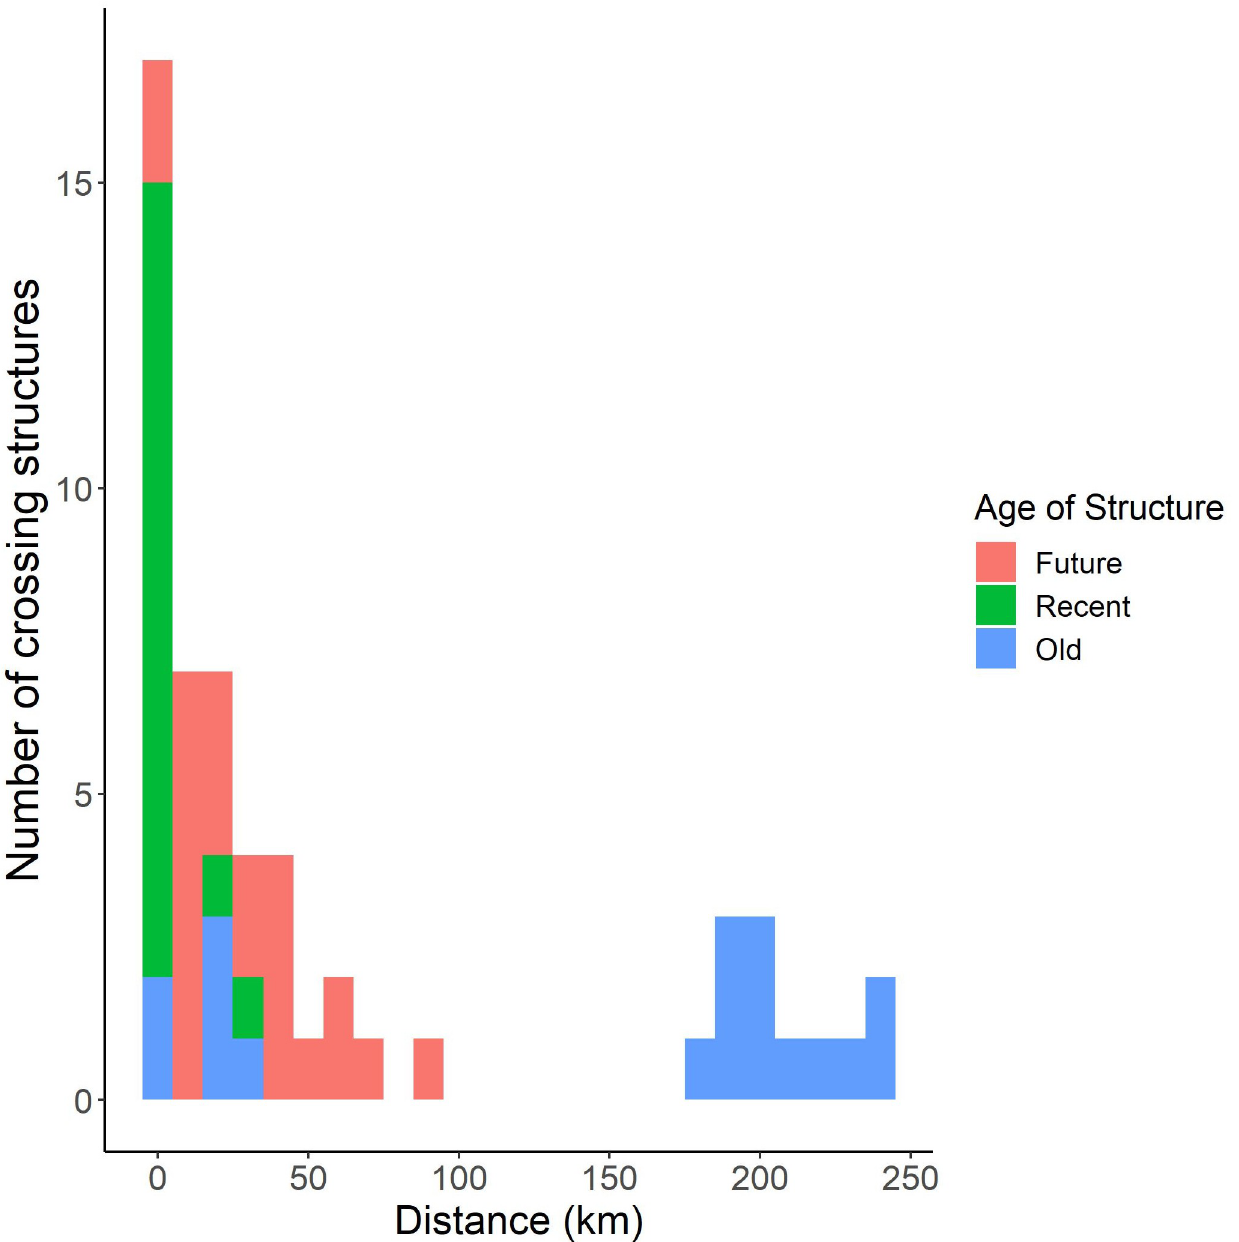
Fig 5. Histogram depicting the distance between each of the 56 crossing structures to the nearest ocelot-vehicle collision site.